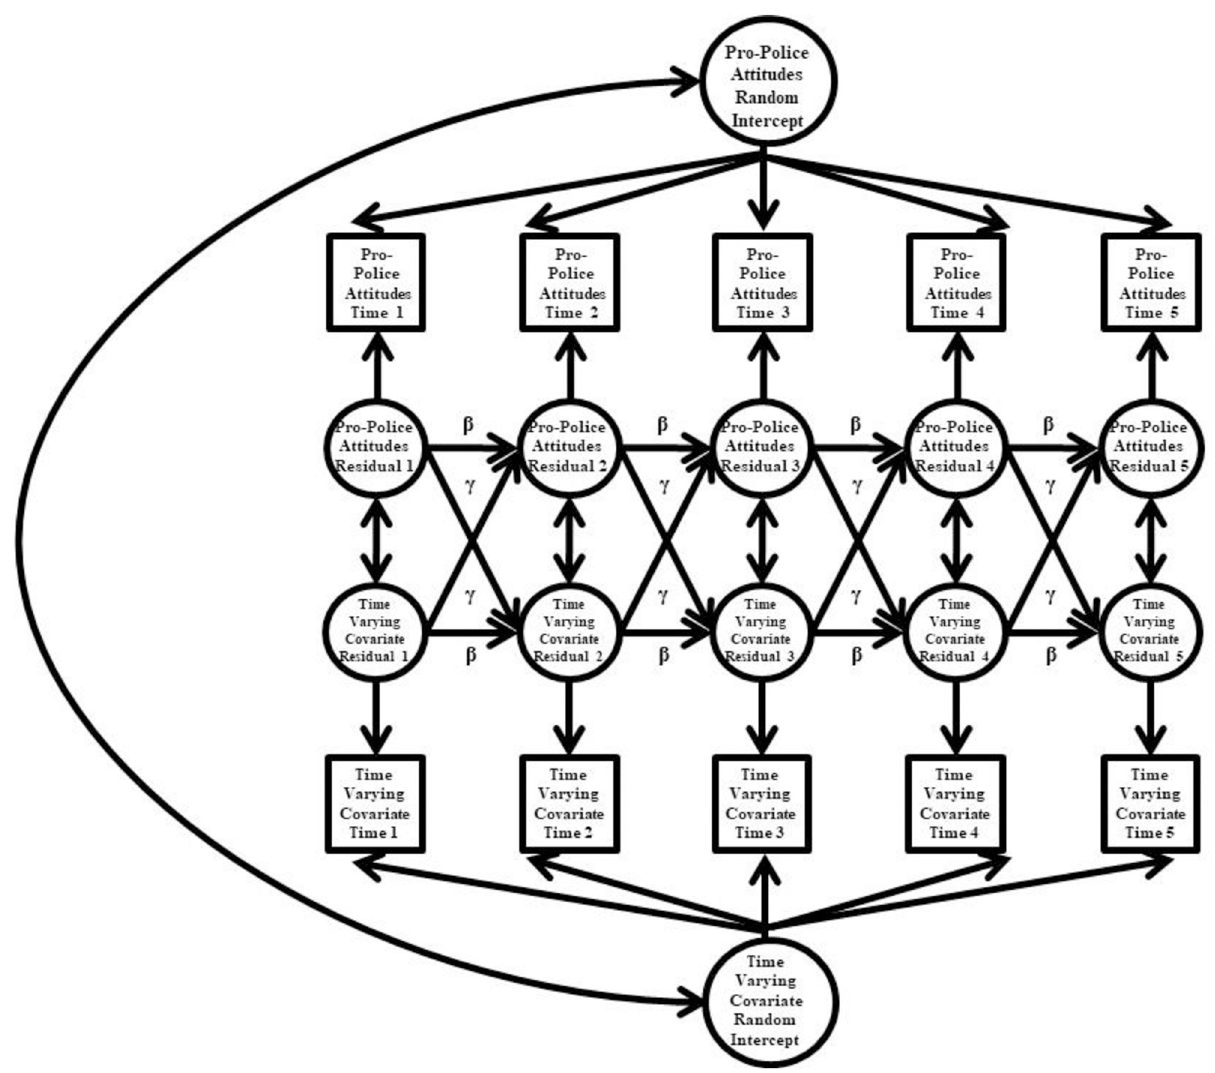
Fig 2. Random Intercept Cross-Lagged Panel Model (RI-CLPM). β = autoregressive path; γ = cross-lagged path. Variances and mean structure omitted from figure for clarity of presentation. All factor loadings were fixed to 1. All autoregressive paths were freely estimated.